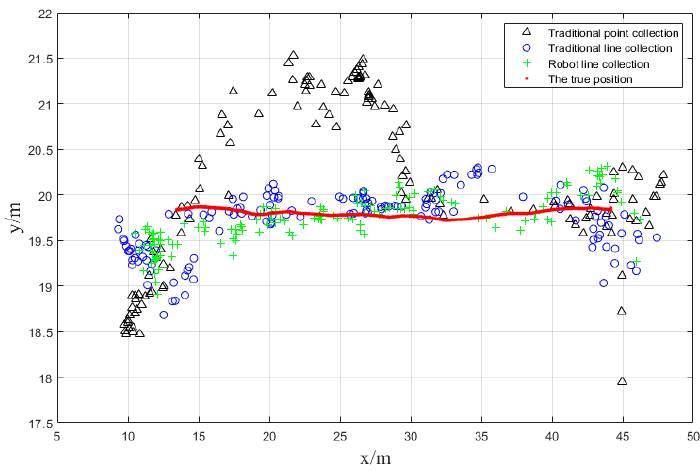
Figure 12. Positioning results of dynamic test.